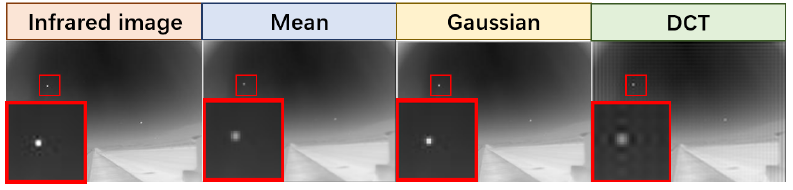
Figure 9. Comparison of filtering effects. Table 6. Effect of filtering on model accuracy for the IoU (%), nIoU (%), P d (%), and F a (10 − 5